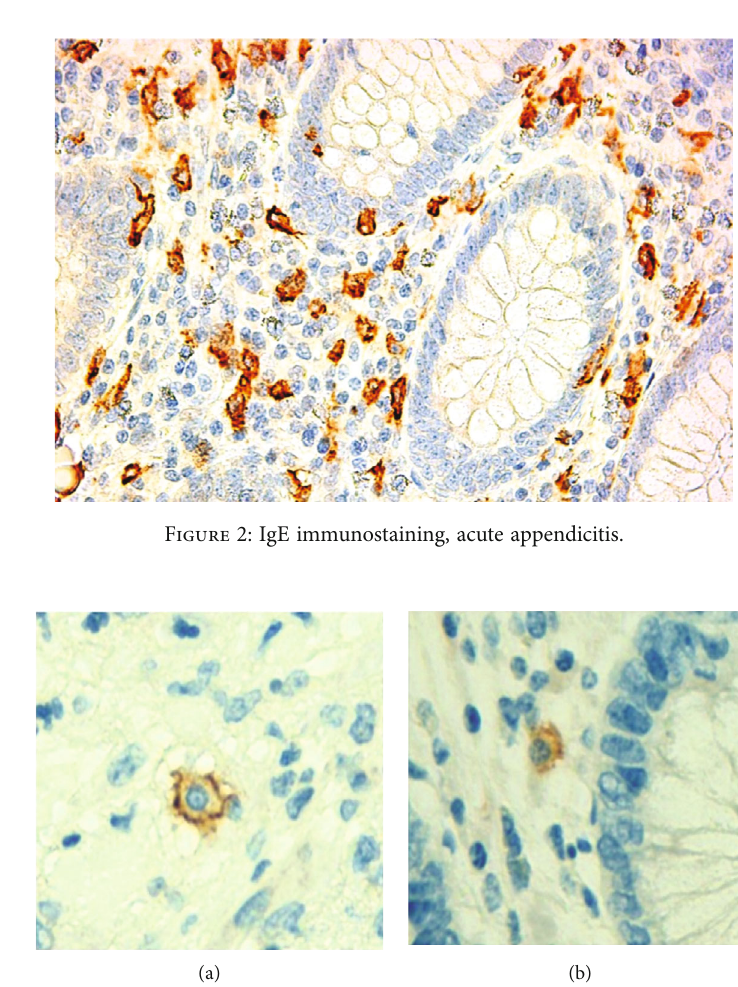
Figure 3: (a) IgE immunostaining, mastocyte. Cytoplasm membrane. (b) IgE immunostaining, plasmocyte. Cytoplasm. Table 2: The distribution of IgE in appendicular